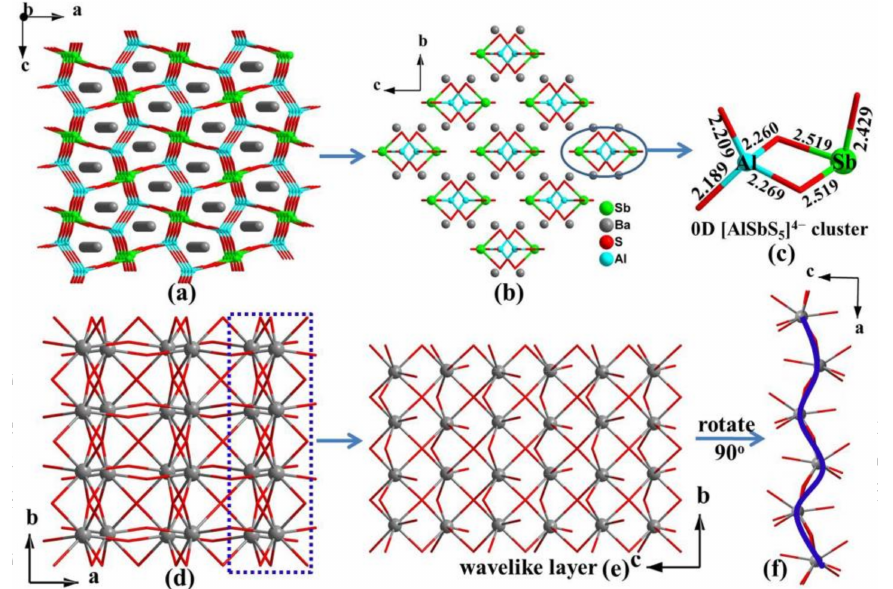
Figure 2. ( a ) Crystal structure of Ba 2 AlSbS 5 with the Ba-S bonds omitted for clarity; ( b ) view of the crystal structure of Ba 2 AlSbS 5 along the a -axis; ( c ) 0D [AlSbS 5 ] 4 − cluster; ( d ) 3D framework structure composed of BaS 8 units; ( e ) one wavelike layer composed of BaS 8 units located at the bc plane; ( f ) view of wavelike layer along the b